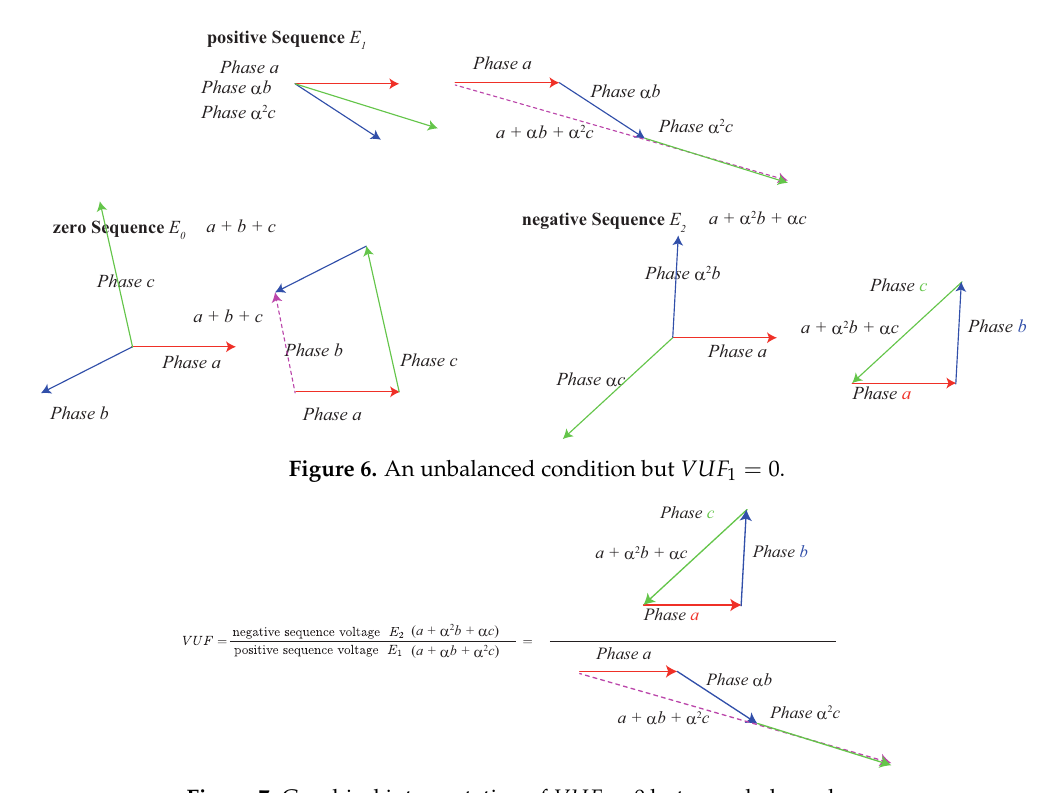
Figure 7. Graphical interpretation of VUF = 0 but an unbalanced